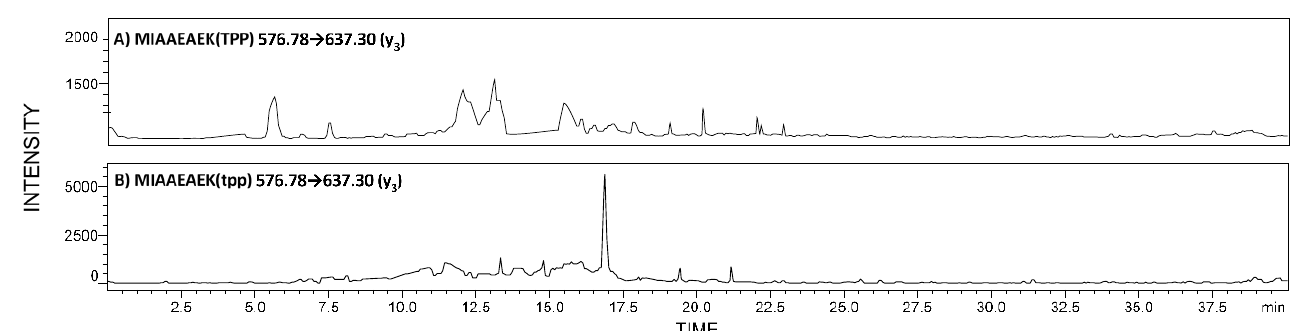
Figure 1. LC-MS/MS analysis of charge derivatized tryptic digests of urine sediment samples from: ( A ) A healthy pregnant women; ( B ) a subject with identified podocin. MRM transitions corresponding to the model peptide with the 292 MIAAEAEK 299 sequence.